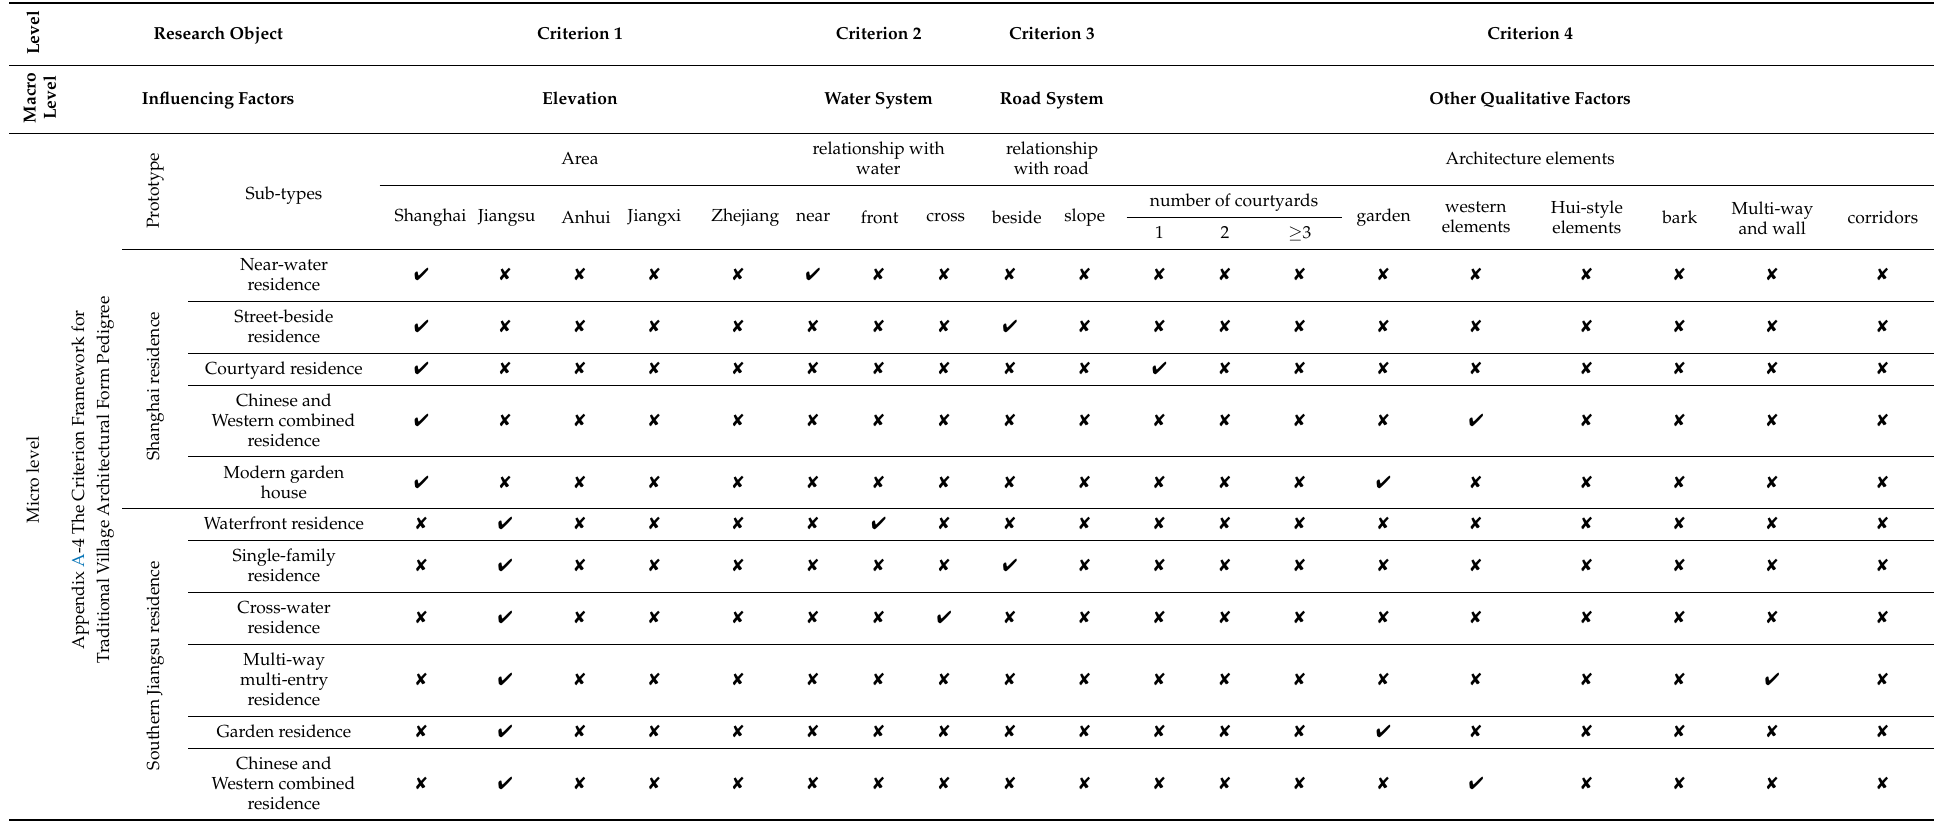
Table A5. The Criterion Framework for Traditional Village Architectural Form Pedigree: Edited by Authors. v e L e